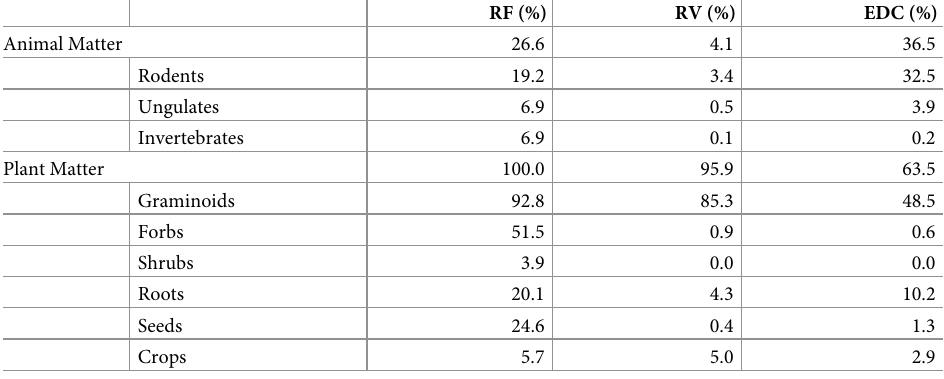
Table 1. Relative frequency (RF), relative volume (RV) and estimated dietary content (EDC) of diet items in brown bear scats from Deosai National Park,